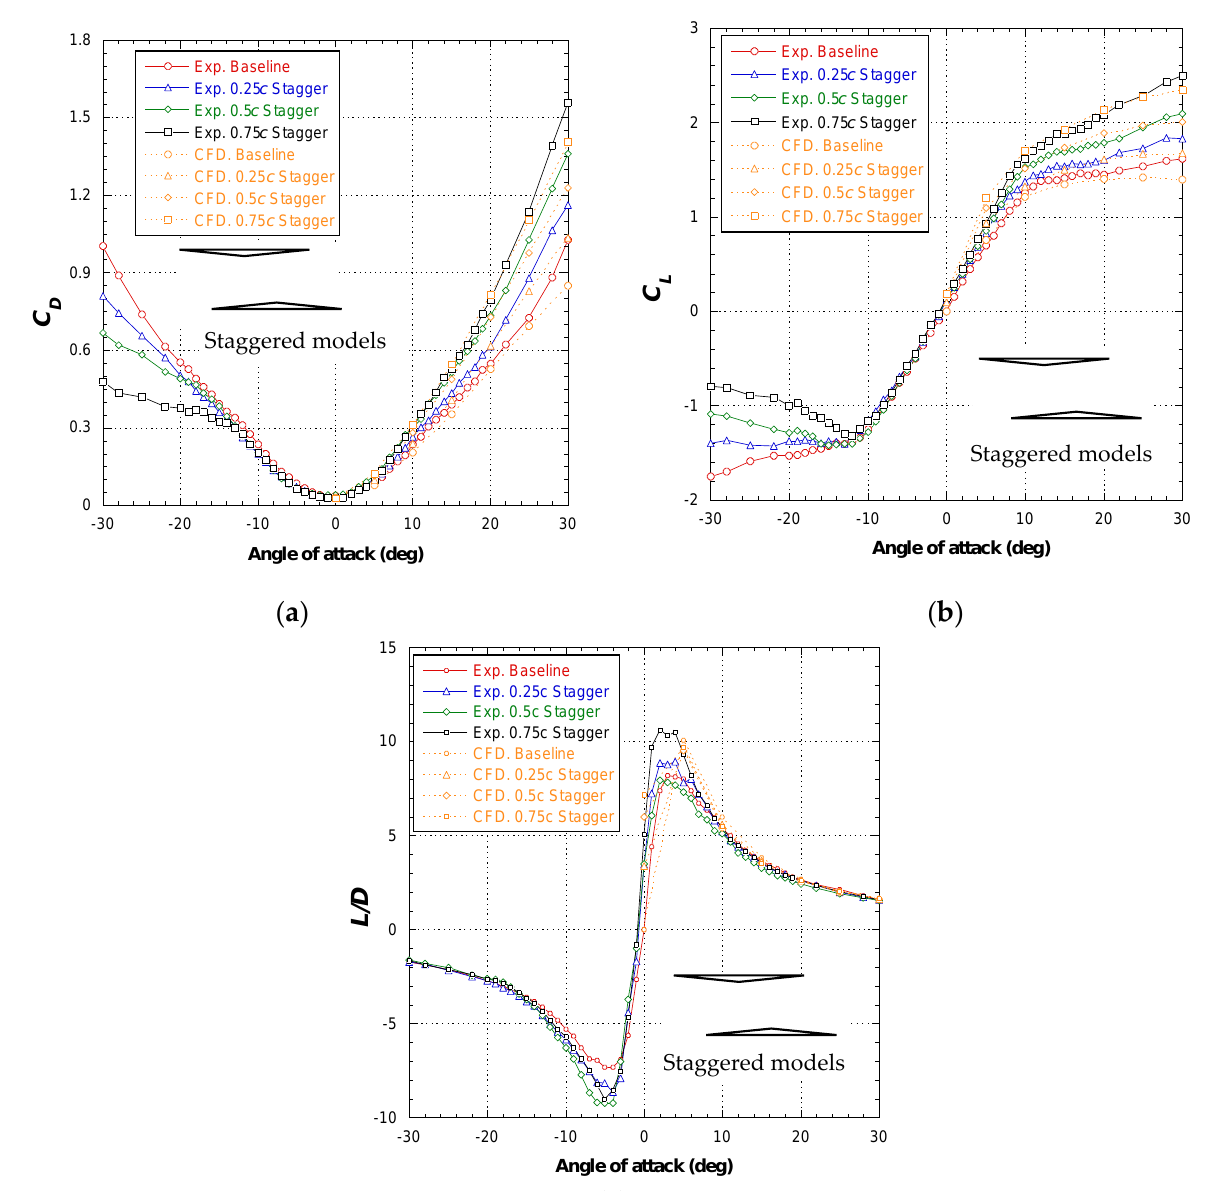
Figure 8. Effect of stagger on aerodynamic characteristics: ( a ) drag coefficient; ( b ) lift coefficient; ( c ) lift-to-drag ratio.